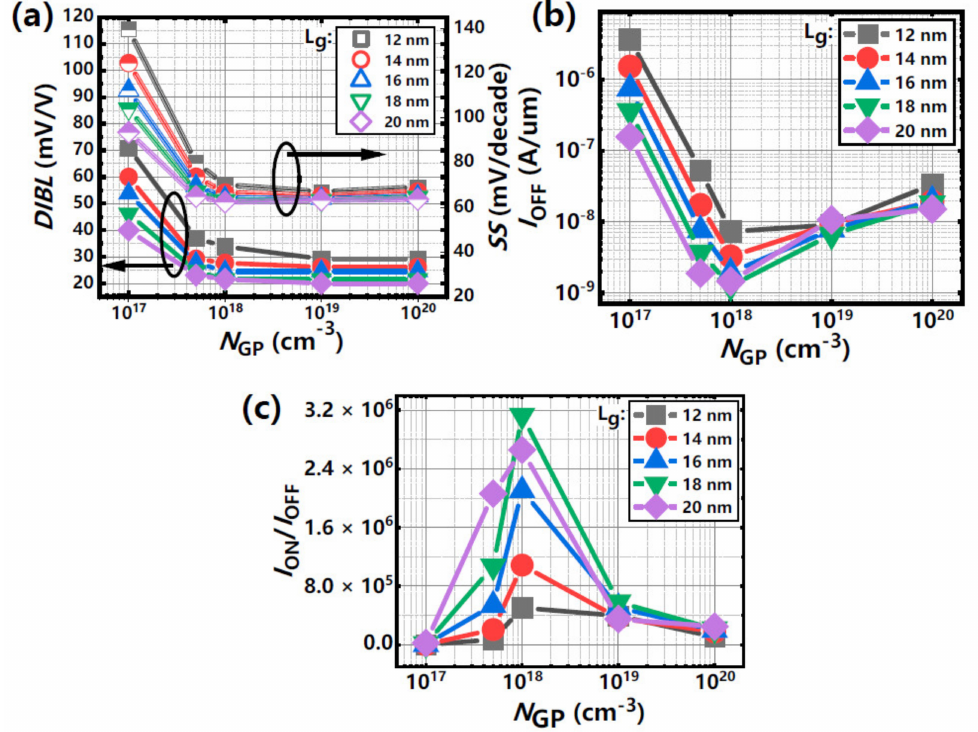
Figure 12. ( a ) DIBL and SS sat , ( b ) I OFF and ( c ) I ON / I OFF ratio extracted from devices with different L g s and GP doping concentration.